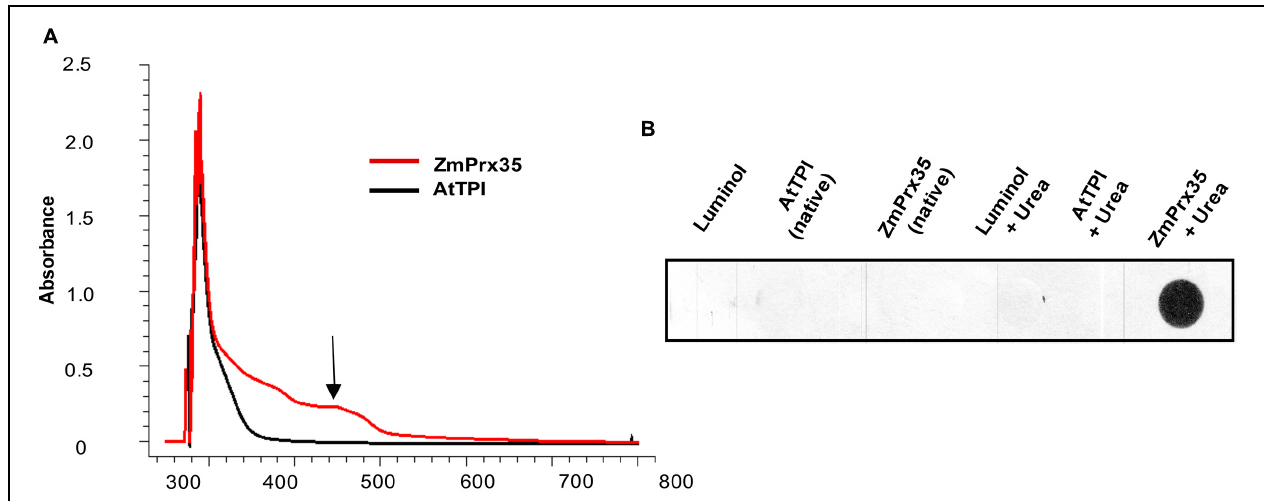
FIGURE 5 | B6T173 (ZmPrx35) iron cofactor detection. (A) Spectra of absorbance (200-800 nm) of ZmPrx35 purified fractions, and of a negative control (At CytoTPI). The arrow shows the peak of absorbance at 450 nm (Soret band). (B) Quantitative luminol assay of ZmPrx35 and AtCyto TPI (as a negative control) under native and unfolded